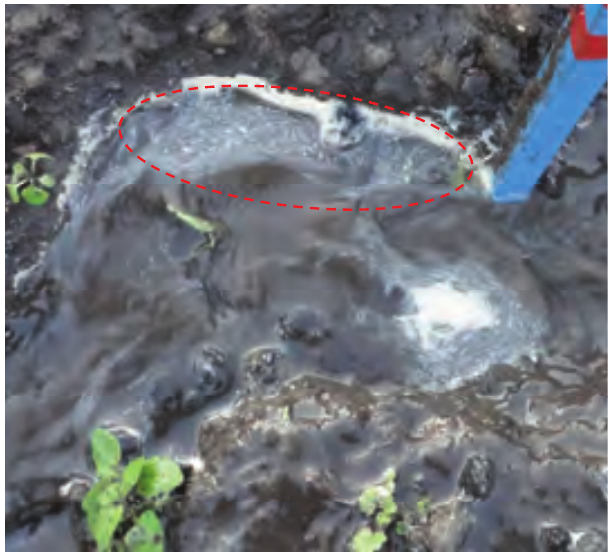
Fig. 5. Beads of smaller diameters trapped at the outside bend of the rill, see red dashed ellipse.